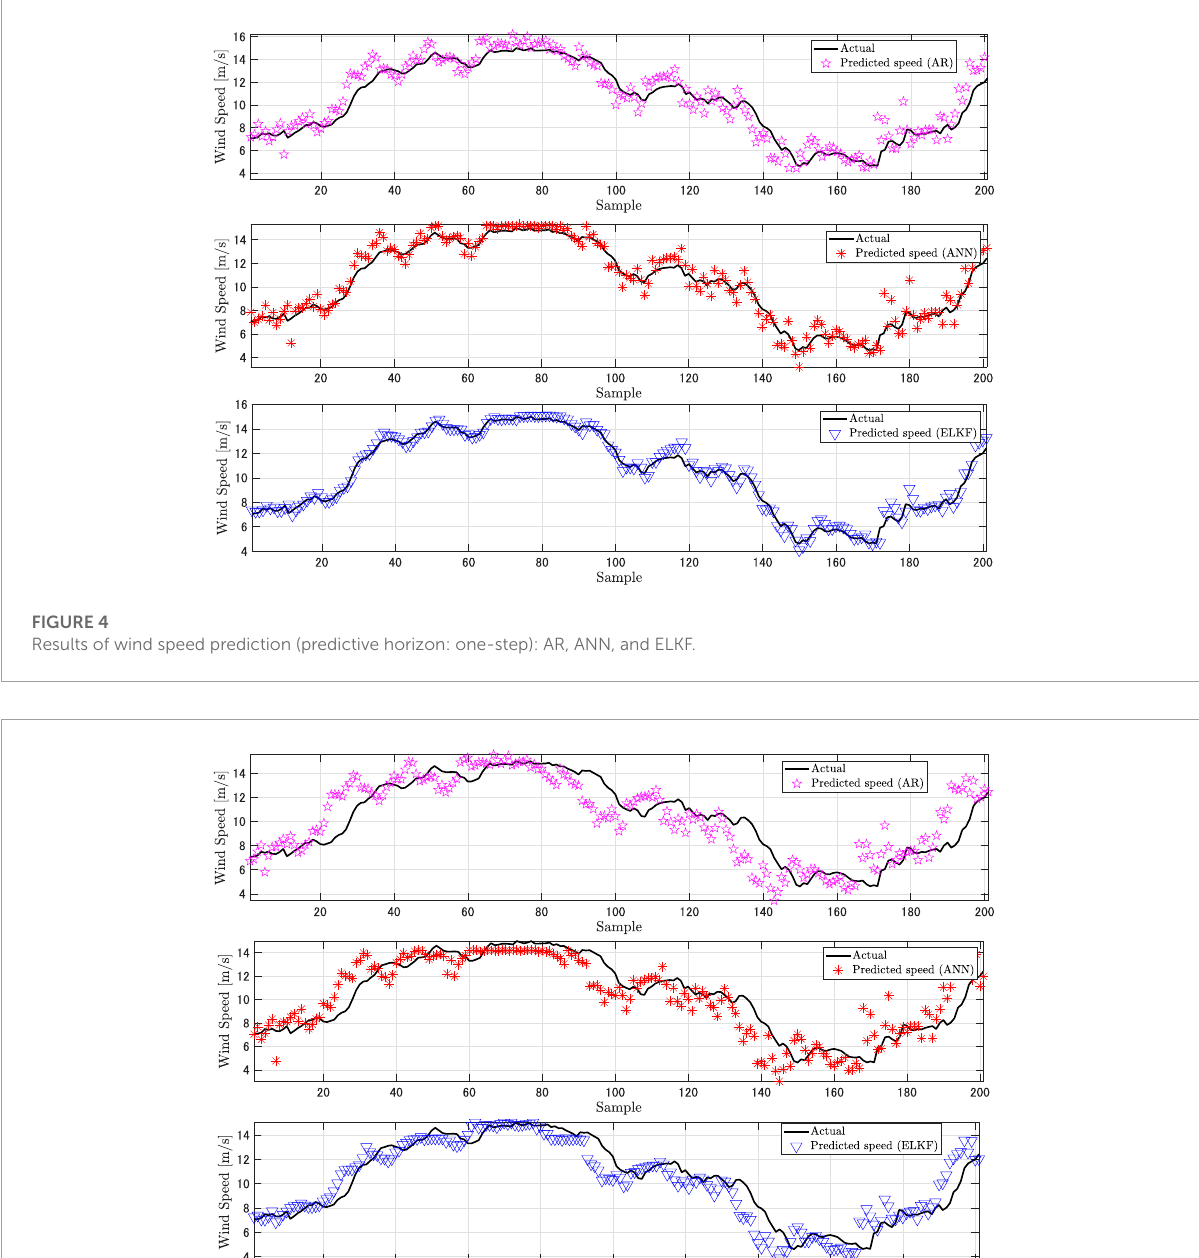
FIGURE 5 Results of wind speed prediction (predictive horizon: five-step): AR, ANN, and ELKF.